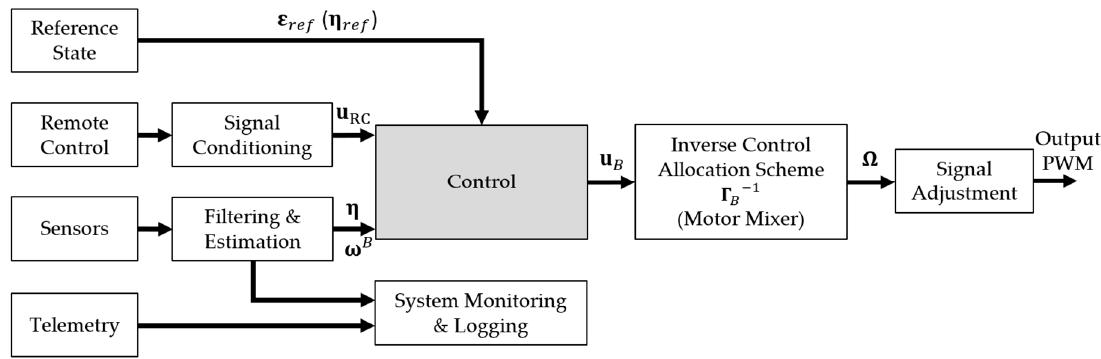
Figure 13. PX4 controller schematic.